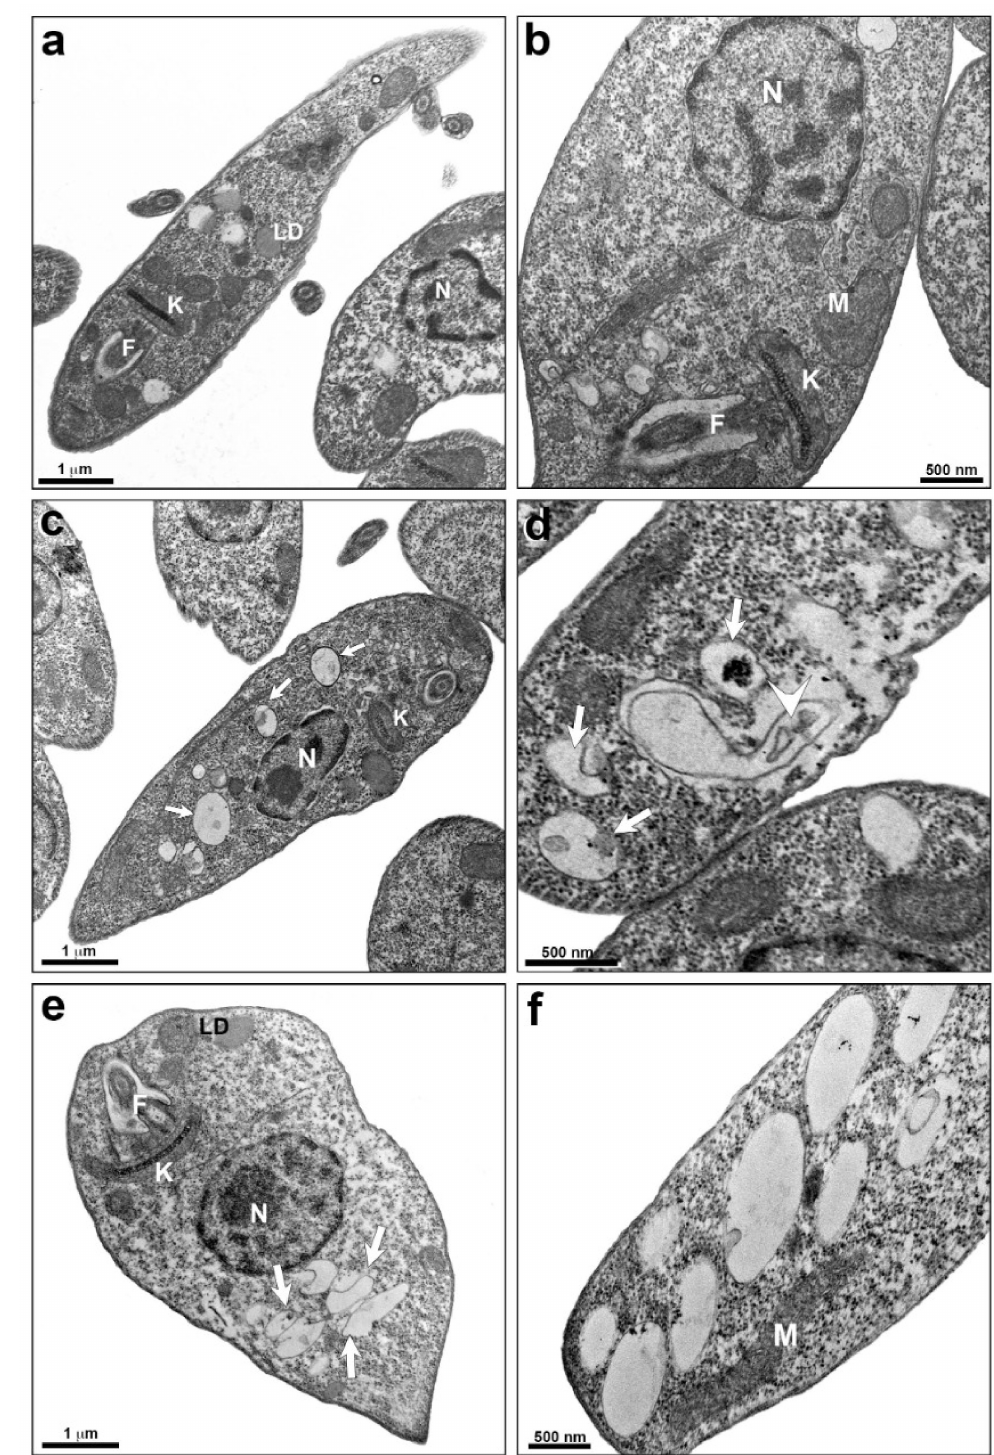
Figure 7. Ultrastructural analysis of L. infantum promastigotes treated with TPCK, as observed by TEM. ( a , b ) Control (untreated cells), note the regular organelle aspect and homogeneous cytoplasm; ( c , d ) promastigotes treated with TPCK at 12 µ M displaying an increased number of cytoplasmatic vacuoles ( c —arrow) and a membranous profile inside some vacuoles ( d —arrowhead); ( e , f ) pro- mastigotes treated with TPCK at 24 µ M, several vacuoles can be observed ( e —arrow). N, nucleus; F, flagellum; K, kinetoplast; M, mitochondria; LD, lipid